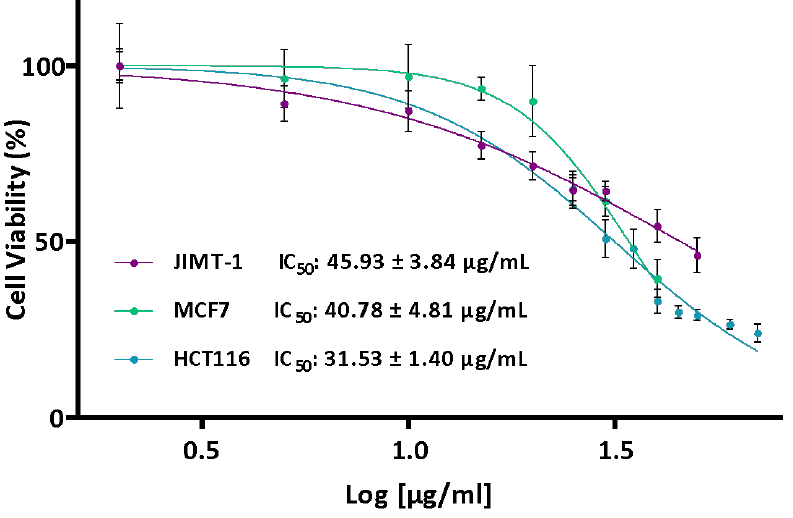
Figure 2. Effect of the SU80 extract on the MCF7 (Green) and JIMT-1 (Purple) breast cancer lines and HCT116 (Blue) colon cancer cell line. The cells were treated with different concentrations of the extract (0–70 µ g/mL) for 24 h. Once the treatment was complete, cell viability was determined using the MTT assay. Values are presented as the percentage of cell viability (%, n = 6). No correlations were observed among the IC 50 values and total polyphenolic content or results for both antioxidant